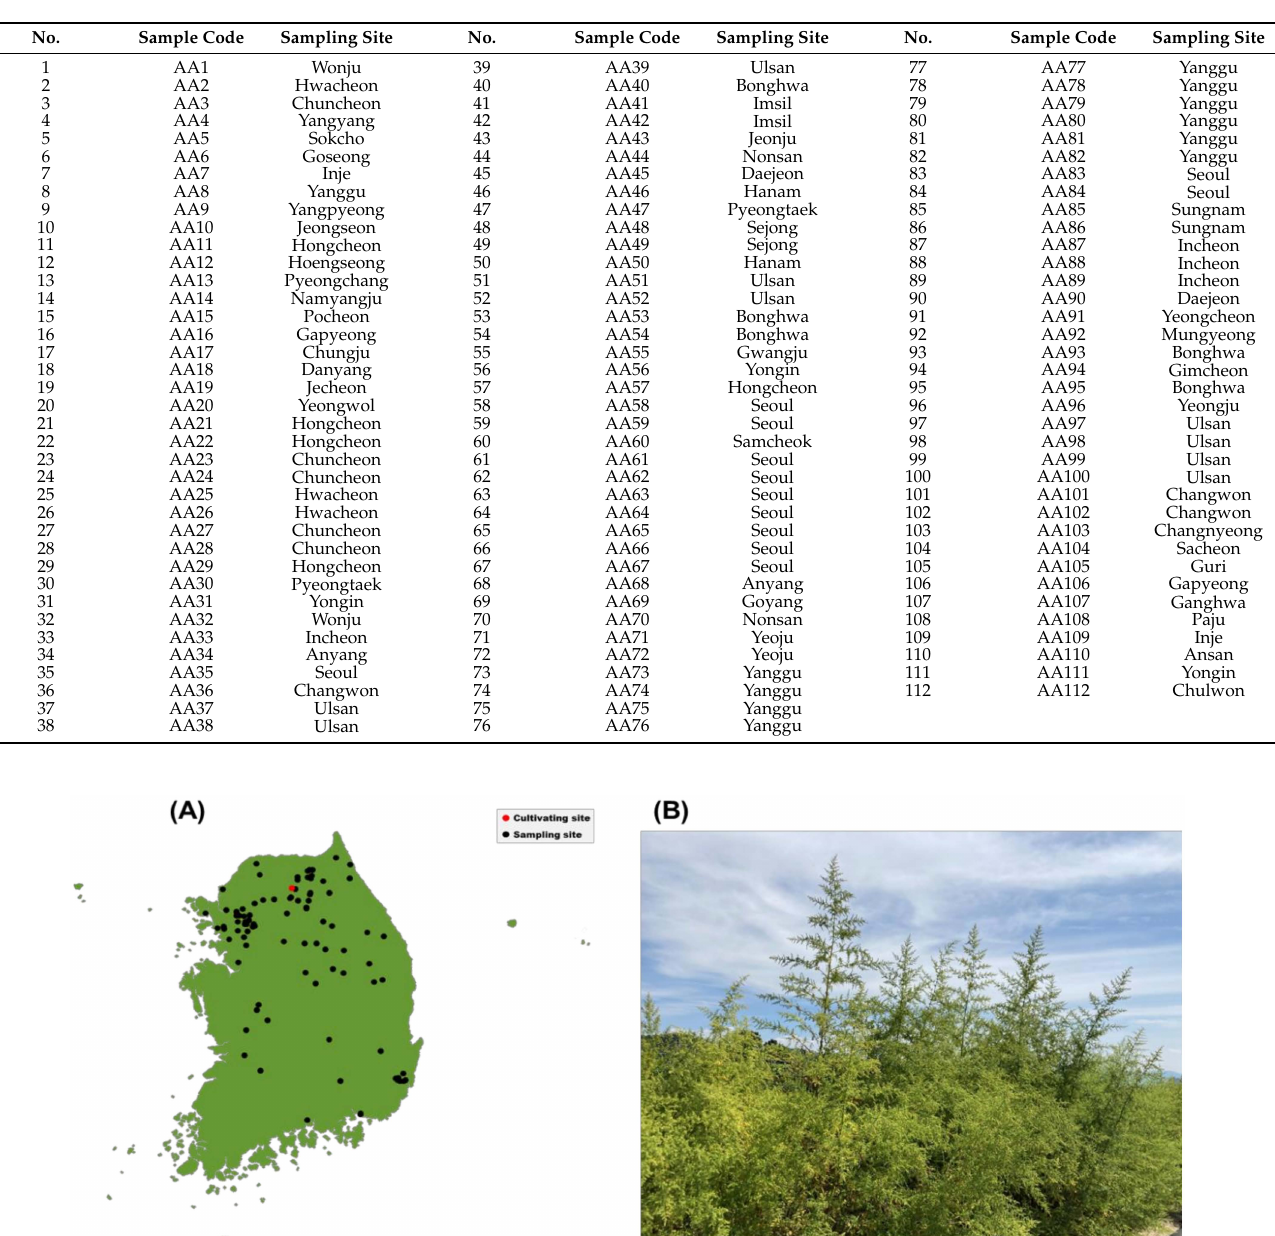
Table 6. Collection sites of A. annua seeds from different places in Korea.